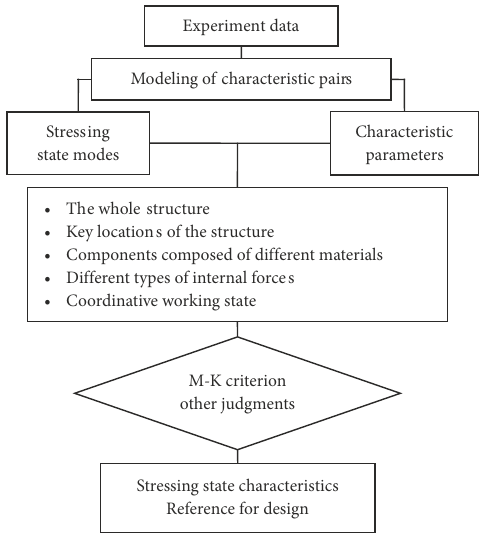
Figure 5. A flowchart of the stressing state analysis of bridge model